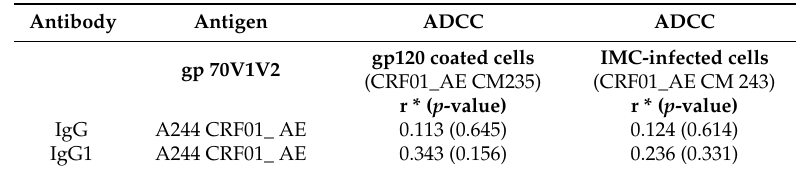
Table 3. No correlation between the magnitude of V1V2 antibodies and ADCC-mediating antibodies four weeks after the second HIV-MVA